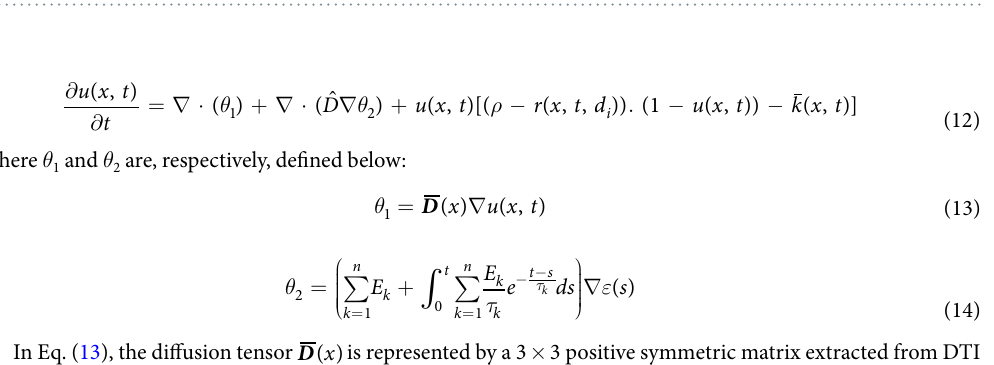
Table 2. The description of the model parameters used in the experiment of the MR